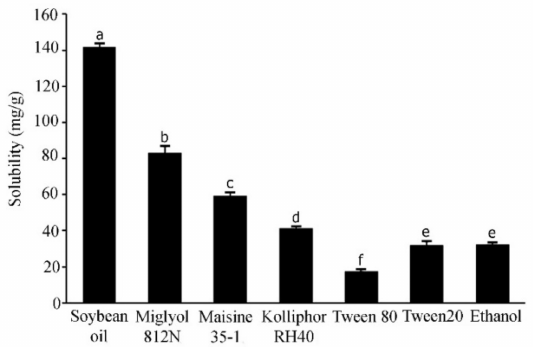
Figure 2. Solubility of APC in various excipients. Different letters indicate significance levels at p <